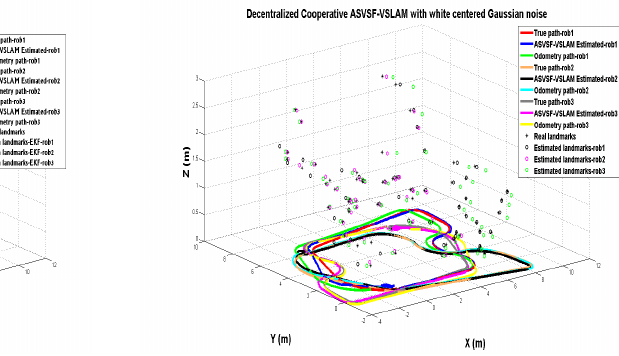
Fig. 5: Visual ASVSF-SLAM simulation results with white centered Gaussian noise.